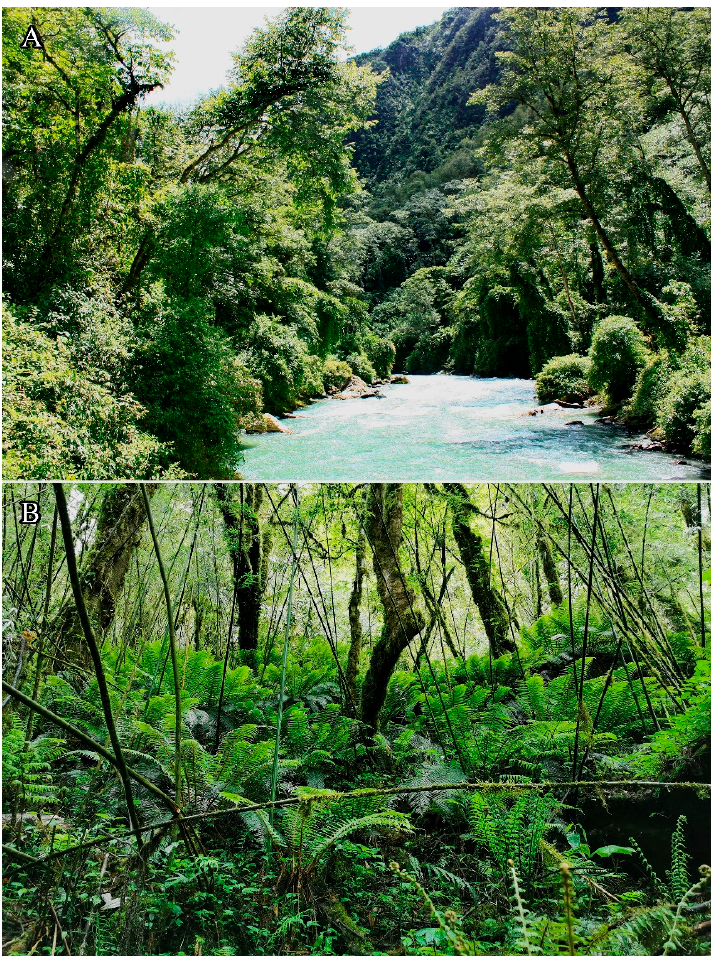
Figure 12. Habitat of Herpetoreas tpser sp. nov. in Mêdog County, southwestern Xizang Autonomous Region, southwestern China. ( A ) Ani Bridge; ( B ) Hanmi. Photographs by Ke Jiang.